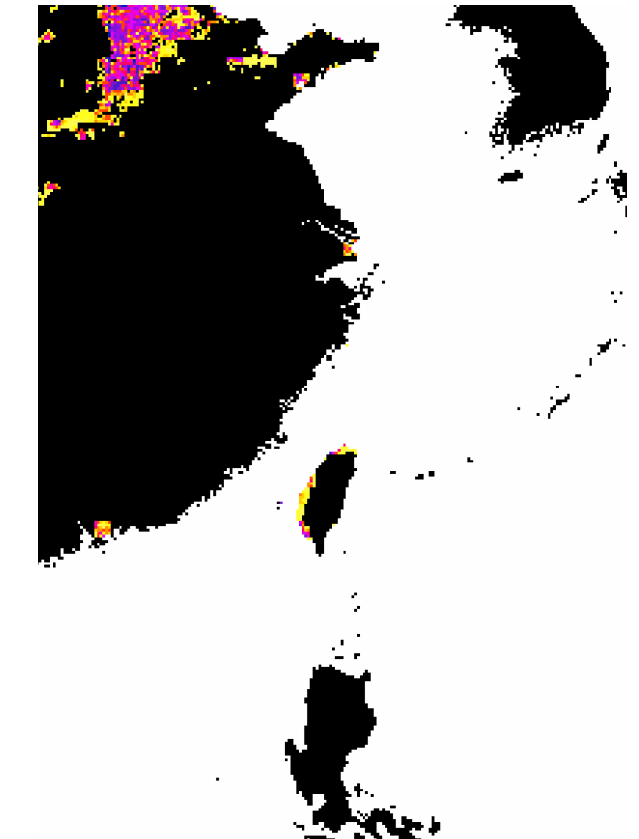
Figure 4. Screen shot of depletion (myr − 1 ) results as calculated by the global hydrology model for the east coast of China and Taiwan. The cities of Hong Kong, Shanghai, Qingdao and Beijing can be recognised. The large area in the north is the North China Plain, which is an agricultural